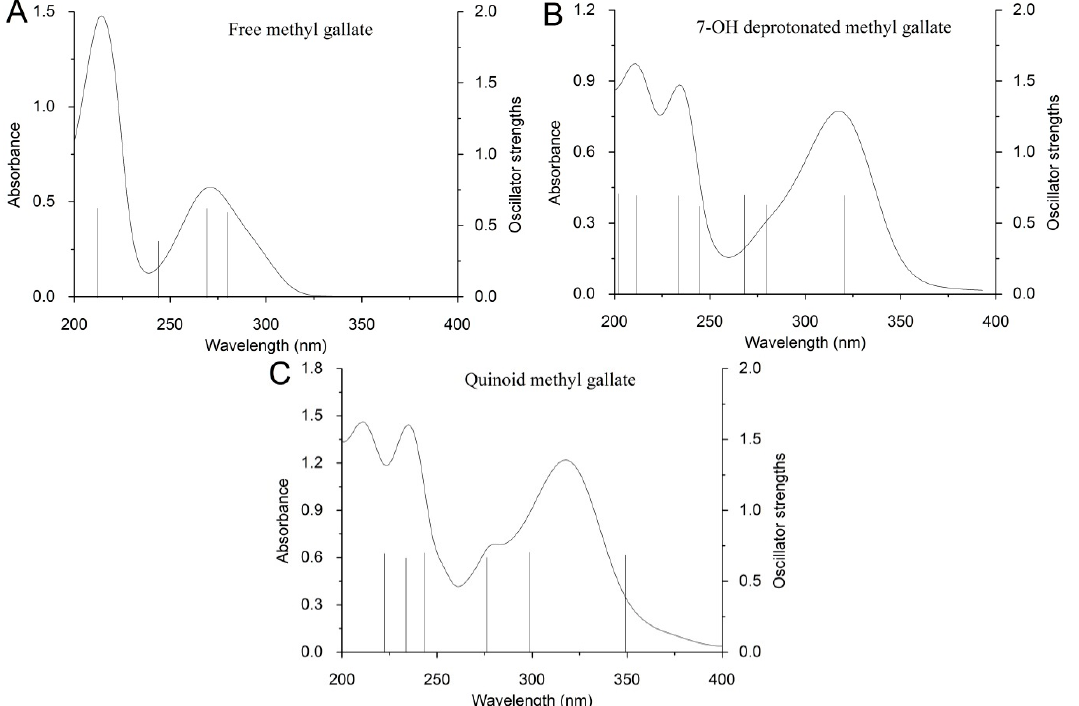
Figure 4. Computed transitions (vertical line) and experimental spectrum (curve) for ( A ) free methyl gallate, ( B ) 7 ‐ OH deprotonated methyl gallate, and ( C ) quinoid methyl gallate.